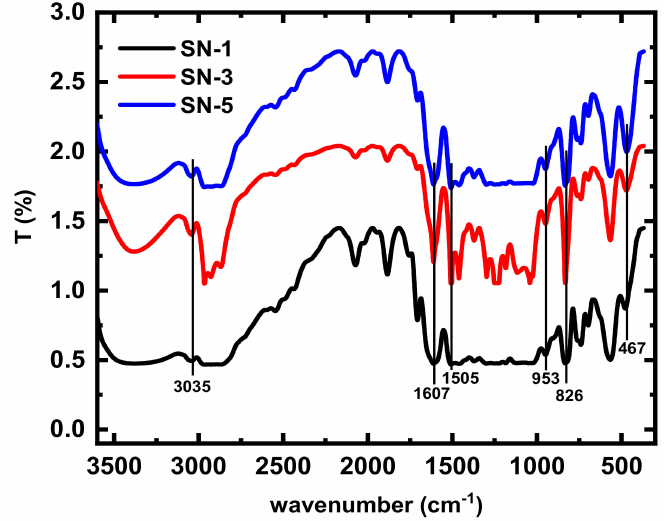
Figure 1. FT-IR Spectra of epoxy coatings with di ff erent percentages of